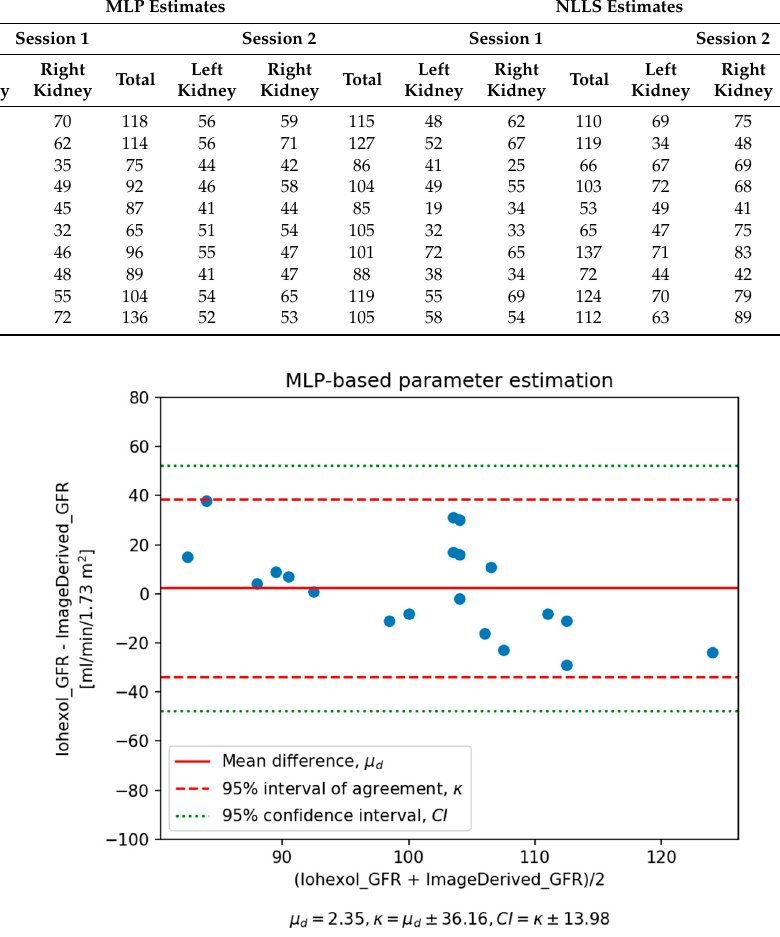
Figure 11. Bland–Altman plot of agreement for MLP-based GFR estimation method. Normal distribution of the measurements was confirmed using Shapiro–Wilk test. The obtained p -values were equal to 0.52 (iohexol-based GFRs) and 0.97 (image-derived MLP-based GFRs).